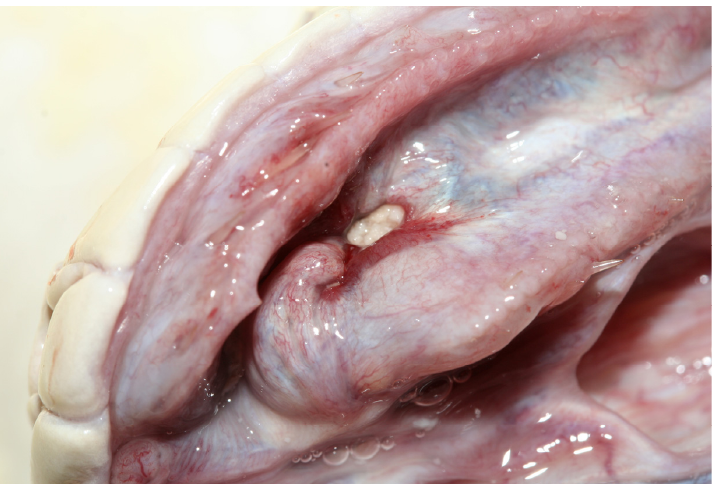
Figure 25. Debris obstructing the combined orifice of the lacrimal duct and vomeronasal organ in the roof of the mouth in a Burmese python ( Python bivittatus ) with pseudo-buphthalmos.